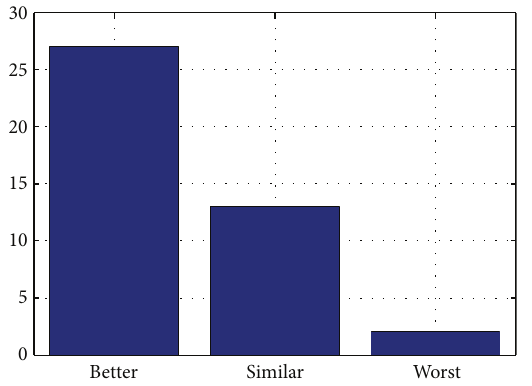
Figure 3: Performance comparison of MDE and